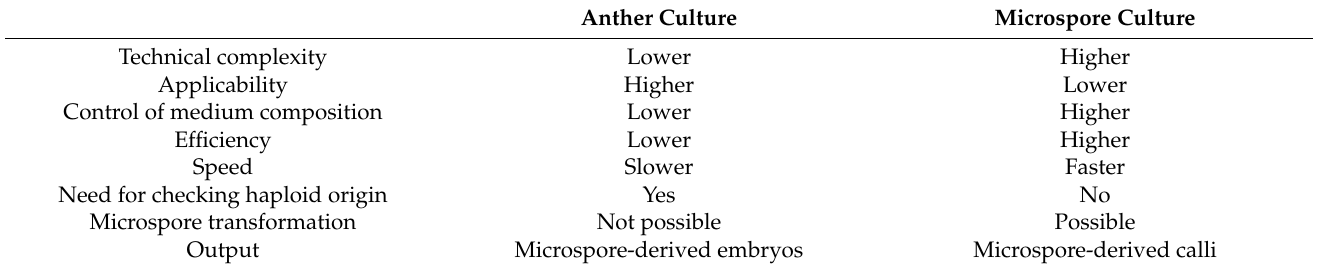
Table 1. Comparison of anther and isolated microspore in vitro culture in